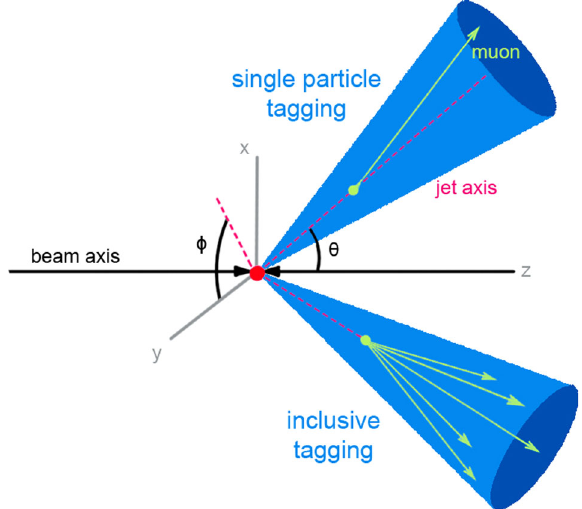
Fig. 4 Illustrative sketch showing an LHCb experiment and the two possible tagging algorithms. A single particle tagging algorithm, exploiting information coming from one single particle (muon), and the inclusive tagging algorithm which exploits the information on all the jet